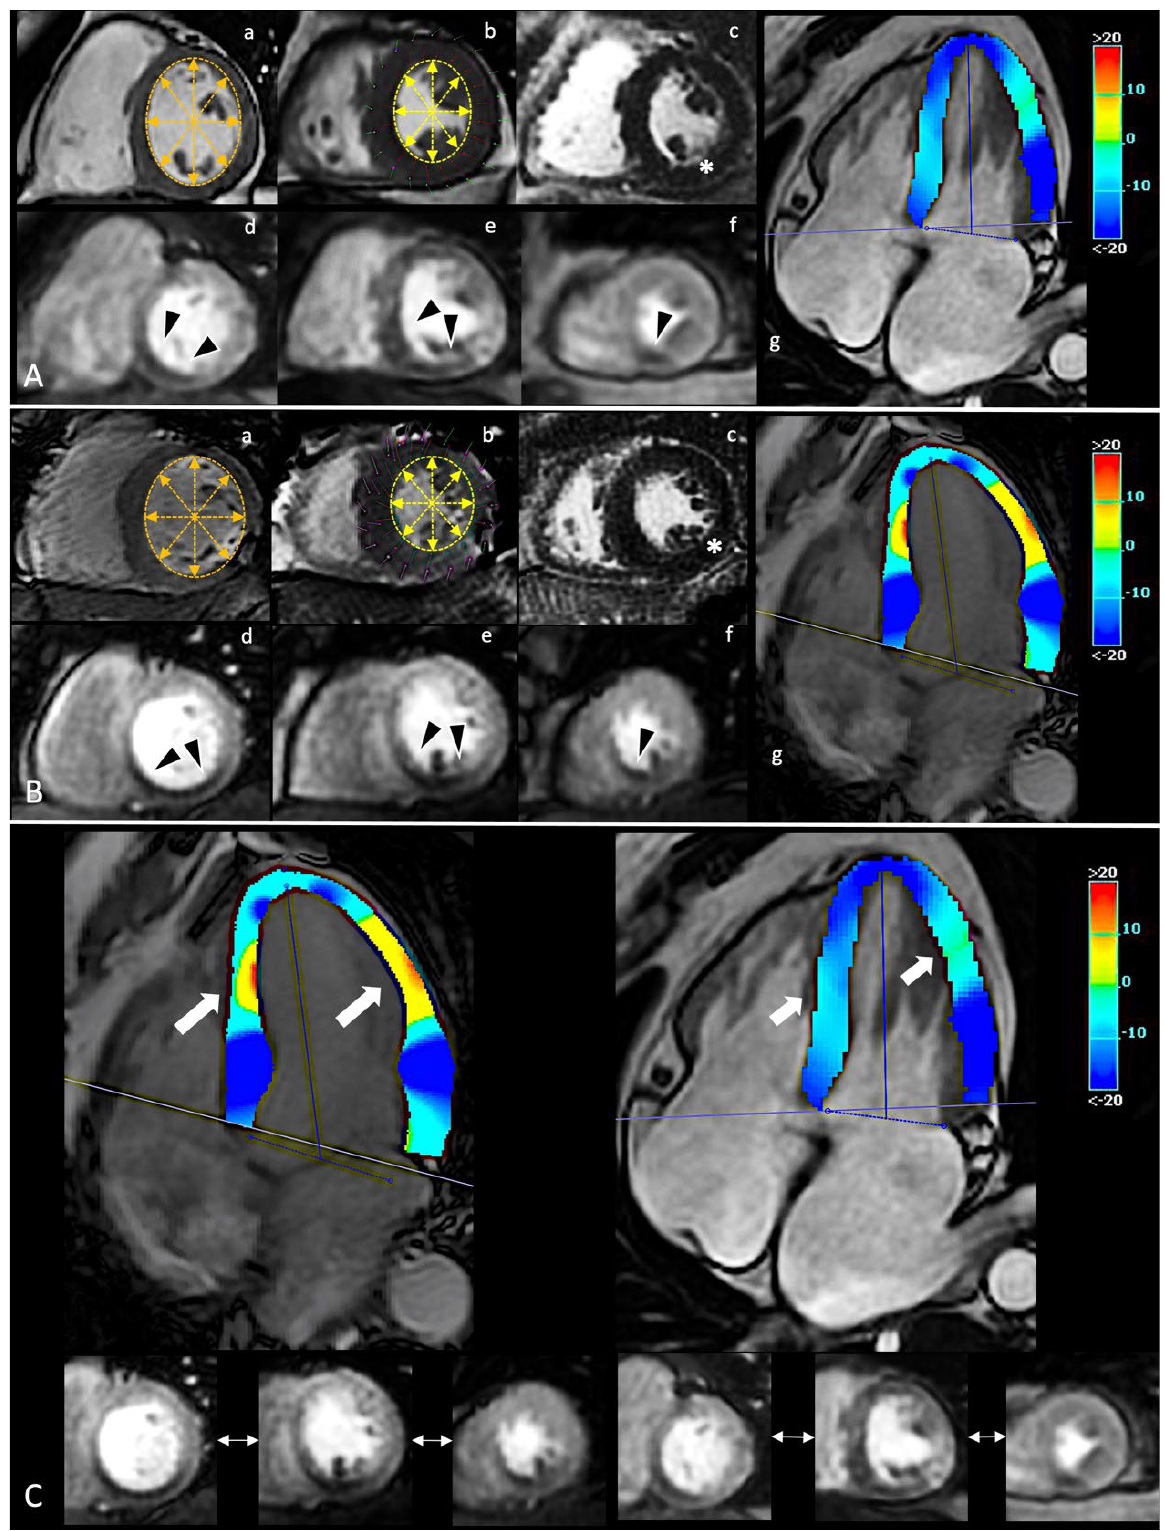
Figure 1. In panel ( A , B ), spCMR findings of two CCS patients. In (a,b), a single frame from SA cine sequence in diastolic and systolic phase, respectively; changes of inner double-arrows lines length highlight preserved systolic contraction. In (c), evidence of no enhancement in LGE sequences (white asterisk). In (d–f), a single frame from first-pass perfusion during adenosine infusion with evidence of similar ischemic burden involved inferior segments from the base to the apex (black arrowheads). In (g), a single systolic frame from HLA cine sequence with superimposed colorimetric map of GLS. On the right, the legend of colorimetric map with correlation between values and col- ors. In panel ( C ), the comparison between the different GLS. Despite a similar ischemic burden, the two patients report different GLS abnormalities (white thick arrows), suggesting a different impact of ischemia on global deformability. GLS acts as accurate index of early global impairment beyond the focal injury. spCMR: stress perfusion cardiac magnetic resonance; CCS: chronic coronary